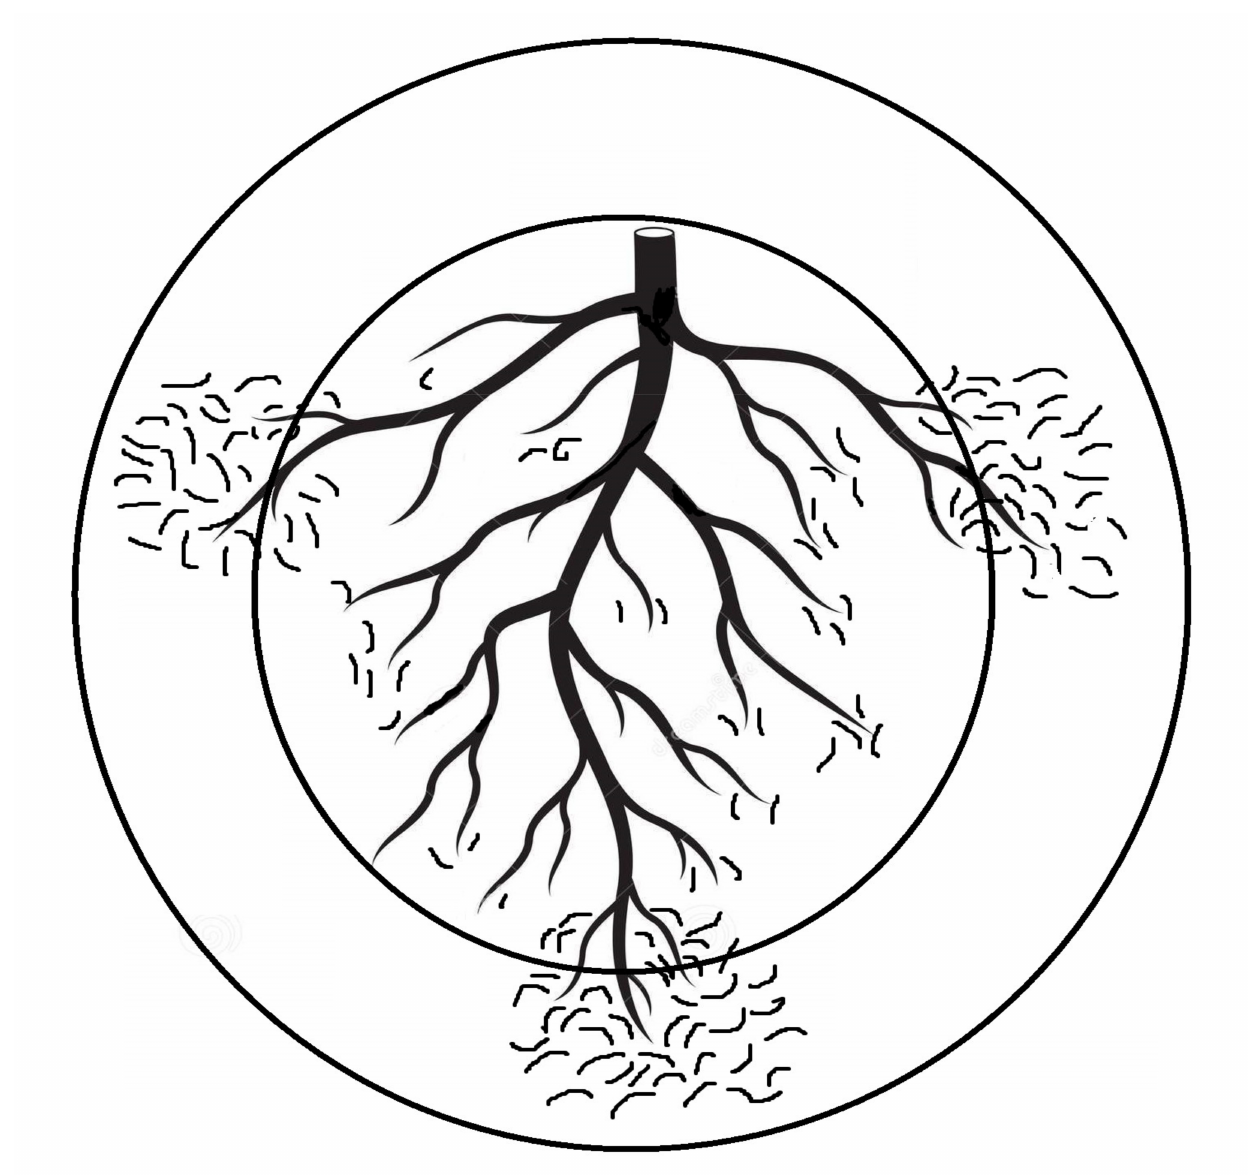
Figure 1. Two quadrat sizes are represented by concentric circles. The inner circle represents random nematode distribution around plant main root and the outer circle represents clumped nematode distribution around lateral fibrous roots as